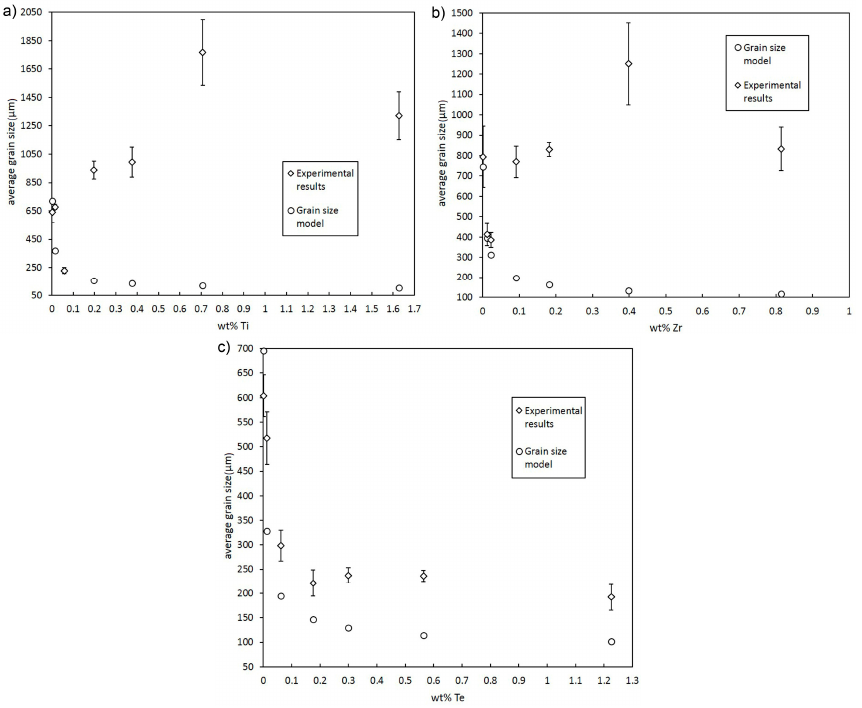
Figure 3. Grain size of Cu with various levels of Ti ( a ), Zr ( b ) and Te ( c ).